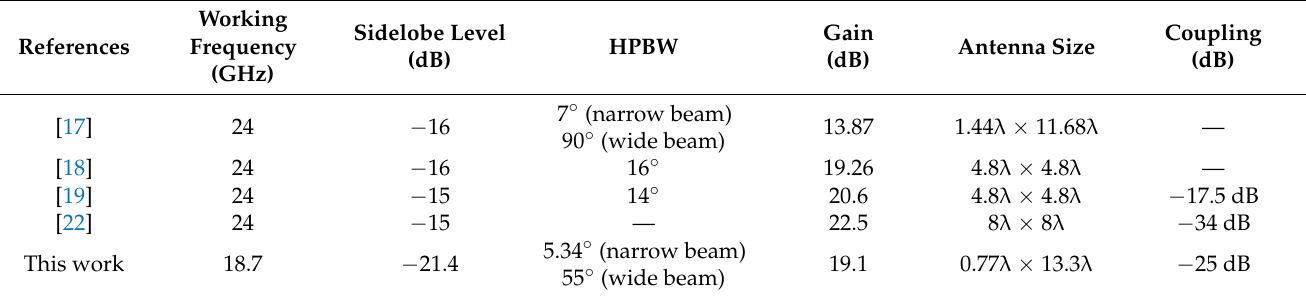
Table 9. Performance comparison of the microstrip grid antennas around K